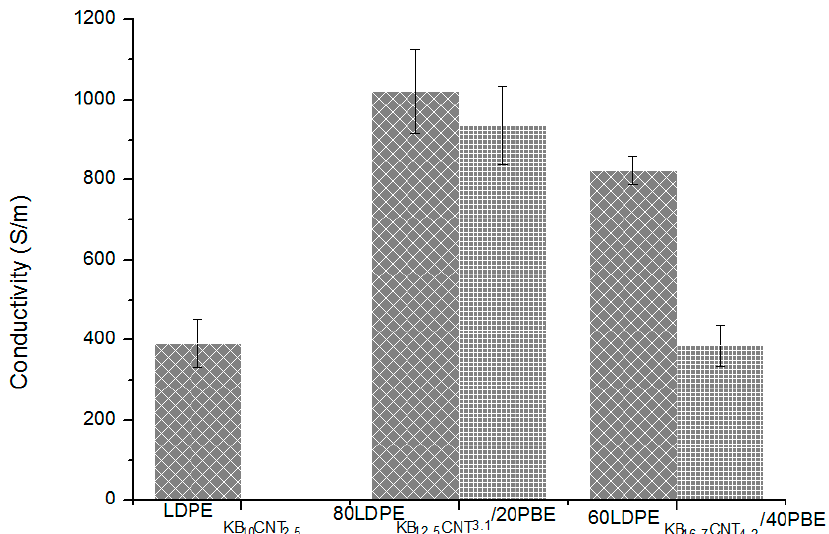
Figure 23. Electrical conductivity (S / m) of the conducting biphasic blends produced by a 1-step Figure 25. Strain (%) of the conducting biphasic blends produced by a 1-step ( ) or 2-step Figure 23. Electrical conductivity (S/m) of the conducting biphasic blends produced by a 1-step ( Figure 25. Strain (%) of the conducting biphasic blends produced by a 1-step ( ) or 2-step ( ) extrusion 3D-printed onto textile materials in the cross ( a ) and machine ( b ) directions of ( )or 2-step ( ) extrusion. ( ) extrusion 3D-printed onto textile materials in the cross ( a ) and machine ( b ) directions of the fabric.